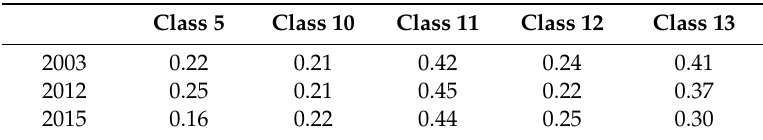
Table 7. Average values of water frequency index (WFI) of the NPW class corresponding to different land use and land cover (LULC) types for 2003, 2012 and 2015.